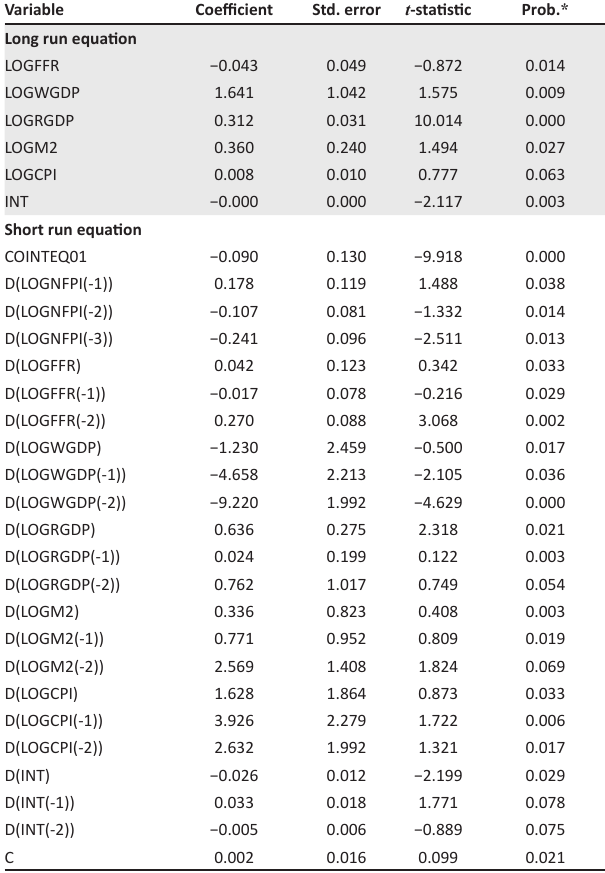
LR, likelihood-ratio; FPE, final prediction error; AIC, Akaike information criterion; SBIC, Schwarz Bayesian information criterion; HQIC, Hannan–Quinn information criterion. ‘ * ’, ‘ ** ’ and ‘ *** ’ represent statistical significance at 10 % TABLE 3: The Panel Autoregressive Distributed Lag regression model.